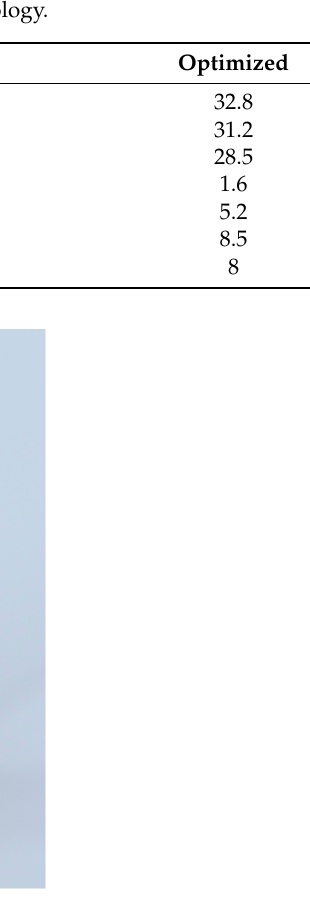
Figure 8. Optimized module for torsion spring.